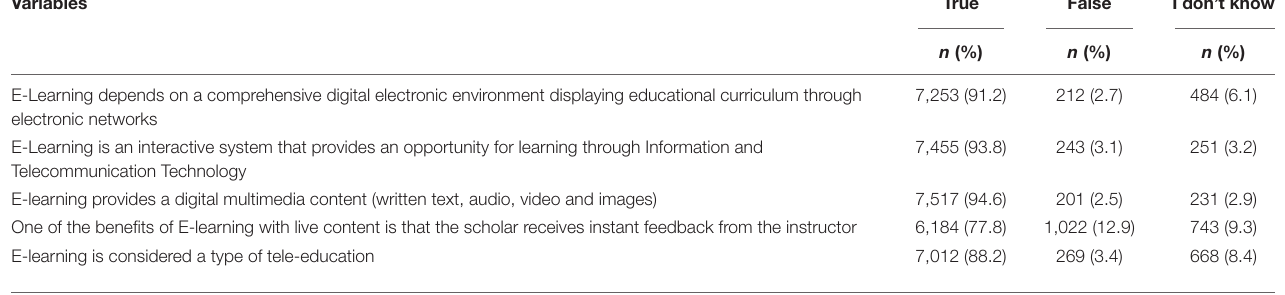
TABLE 6 | Attitudes of medical students toward